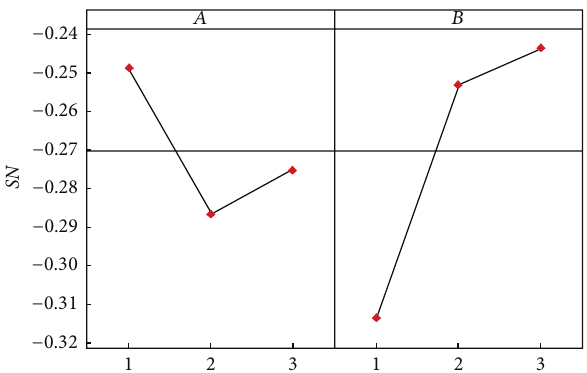
Figure 2: Main effect plots for 𝑆𝑁 ratio of Dermatology